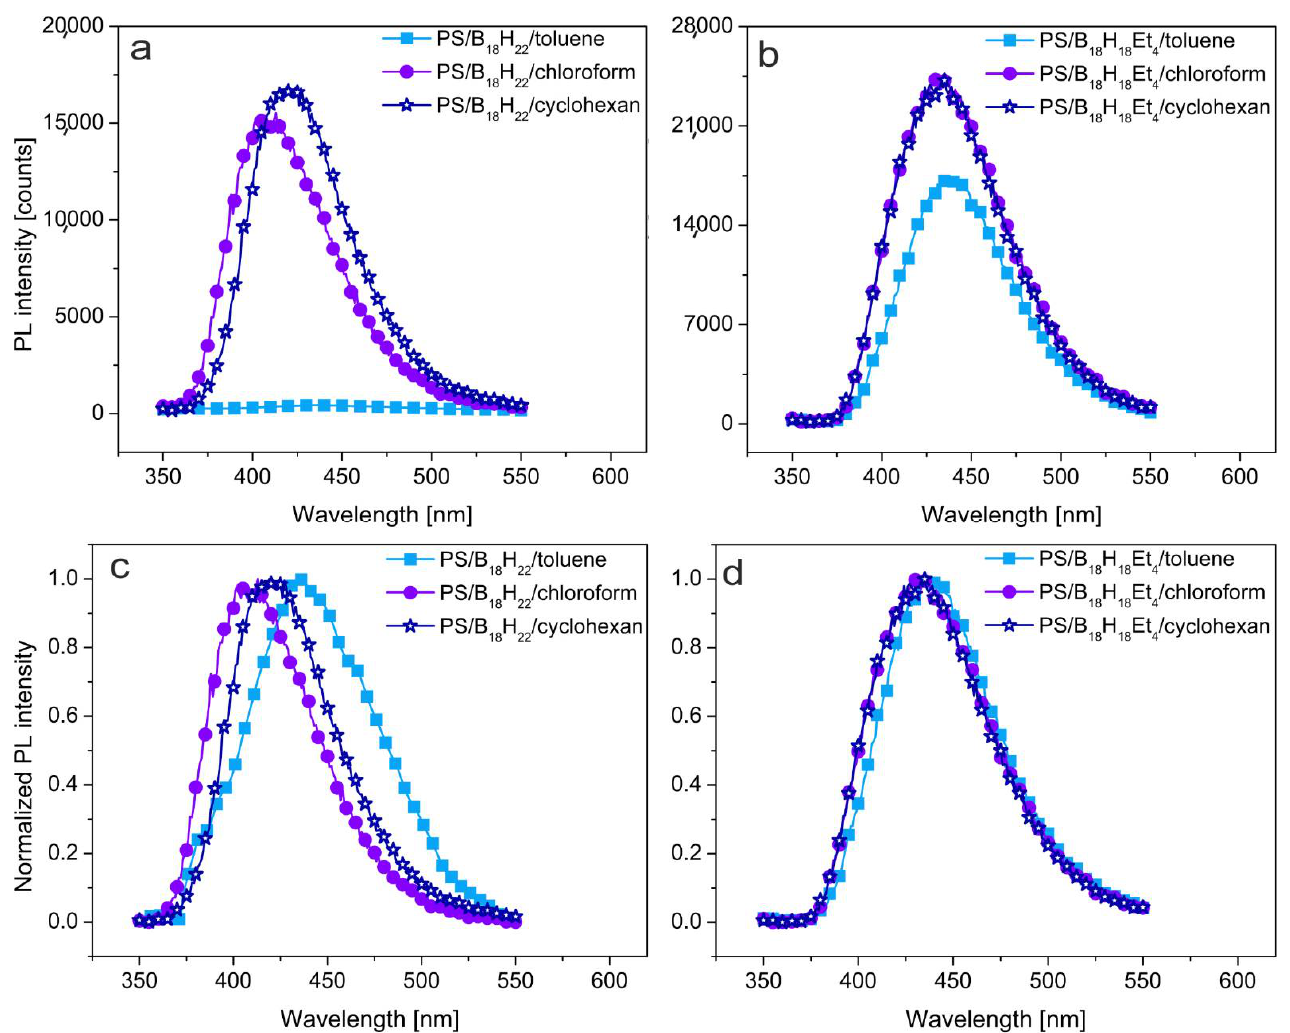
Figure 5. Photoluminescence emission spectra of ( a ) anti -B 18 H 22 and ( b ) 3,3′,4,4′-Et 4 - anti -B 18 H 18 in solutions with polystyrene, ( c , d ) are their normalized form. Excitation wavelength λ exc = 340 nm for all samples.